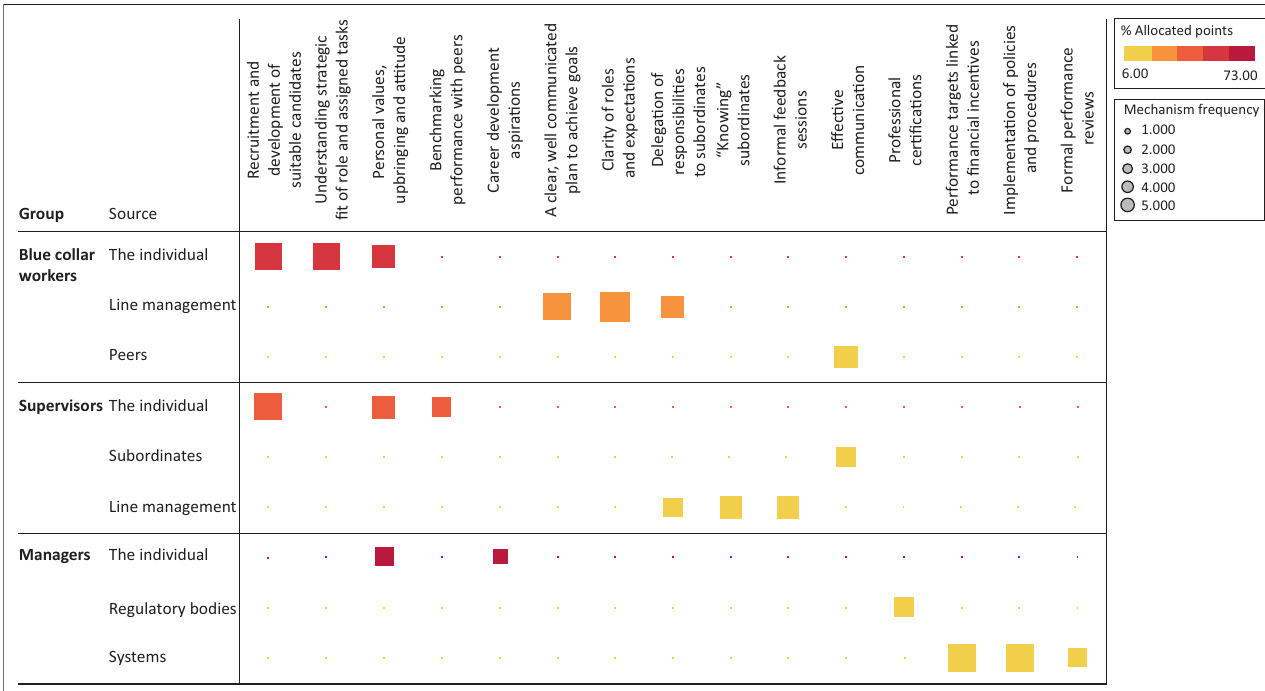
FIGURE 1: Accountability prioritisation heat map in mining organisations.